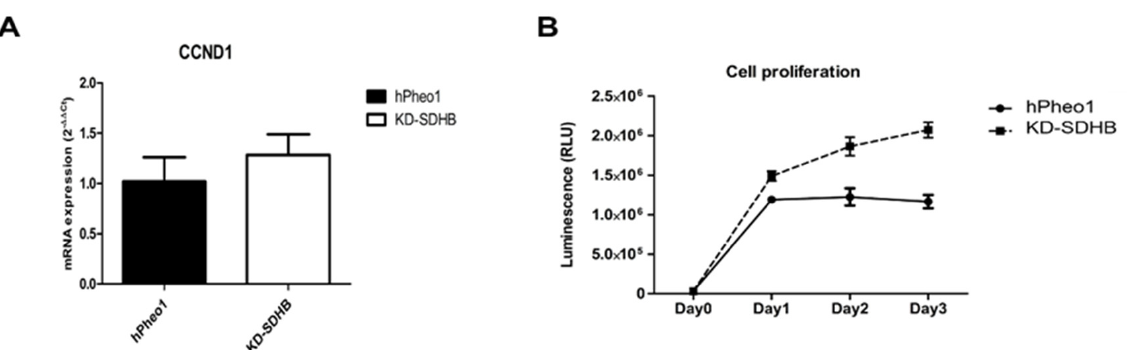
Figure 2. ( A ) Expression of CCND1 mRNA using RT-qPCR. ( B ) Cell growth test at 1, 2, and 3 days after plating of hPheo1 and KD-SDHB hPheo1 cells, based on luminescence generated by living and proliferating cells. Data represent the mean ± standard deviation ( n = 3), student’s t -test.